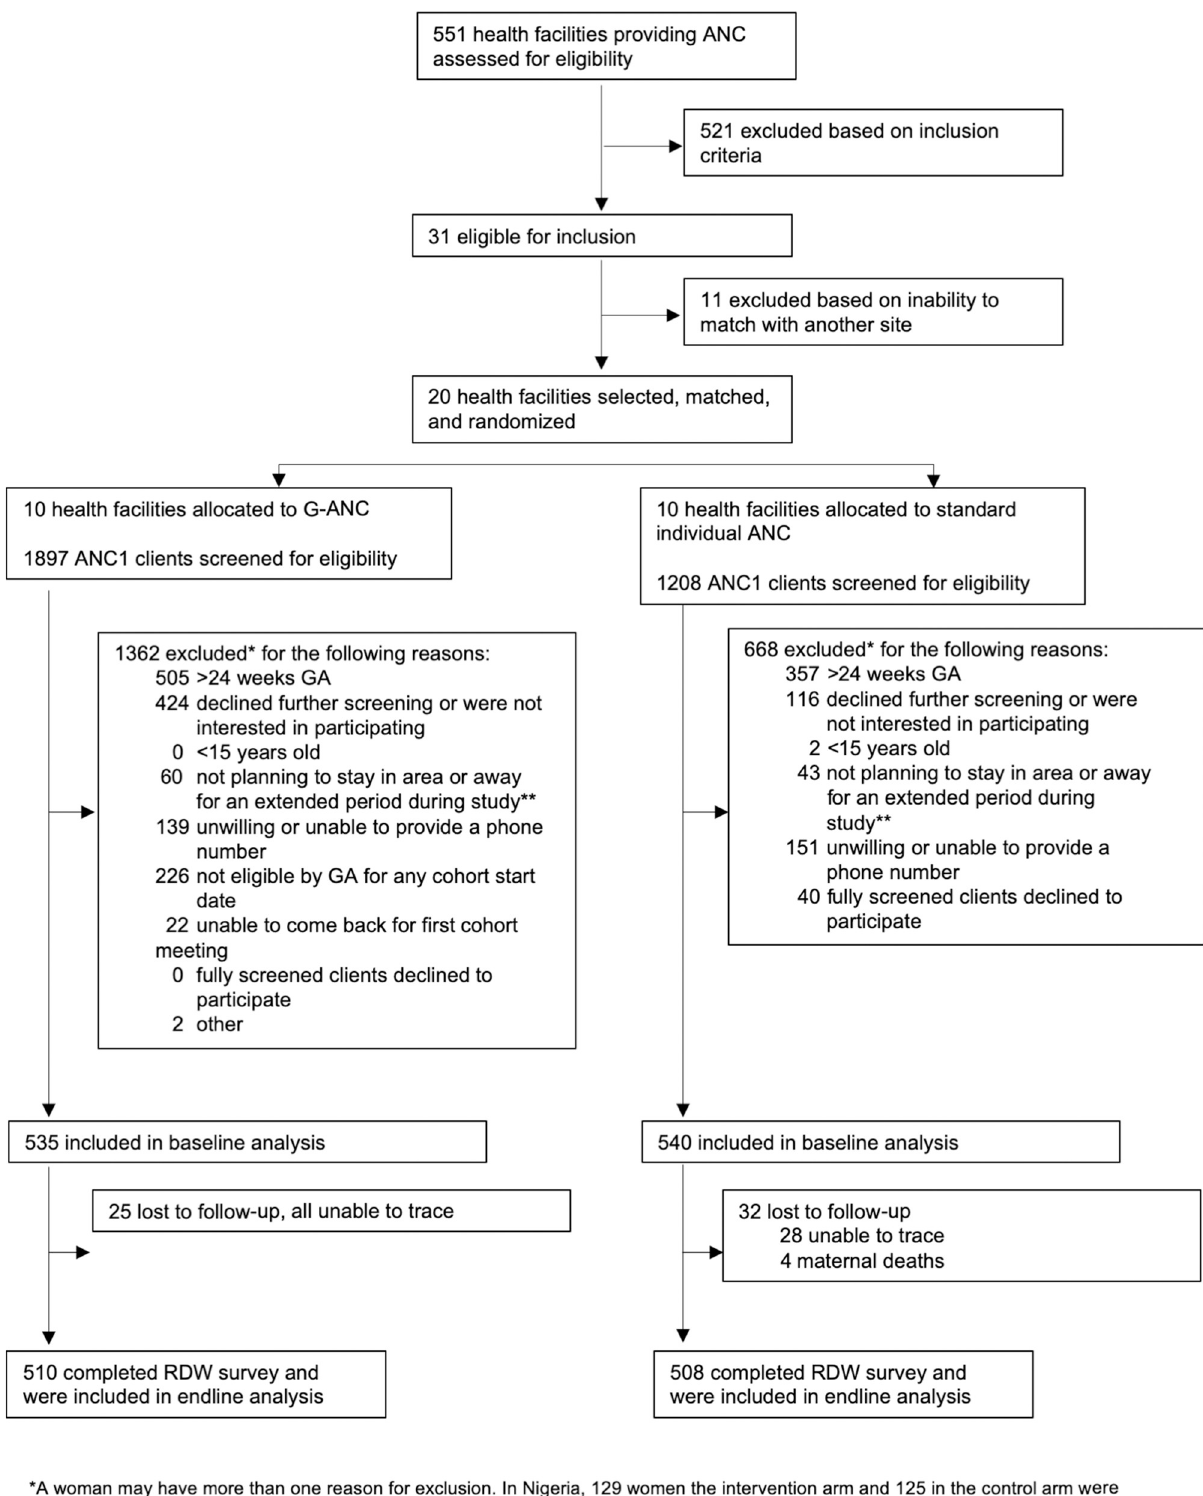
Fig 1. Trial Profile Nigeria. https://doi.org/10.1371/journal.pone.0222177.g001 PLOS ONE | https://doi.org/10.1371/journal.pone.0222177 October 2,